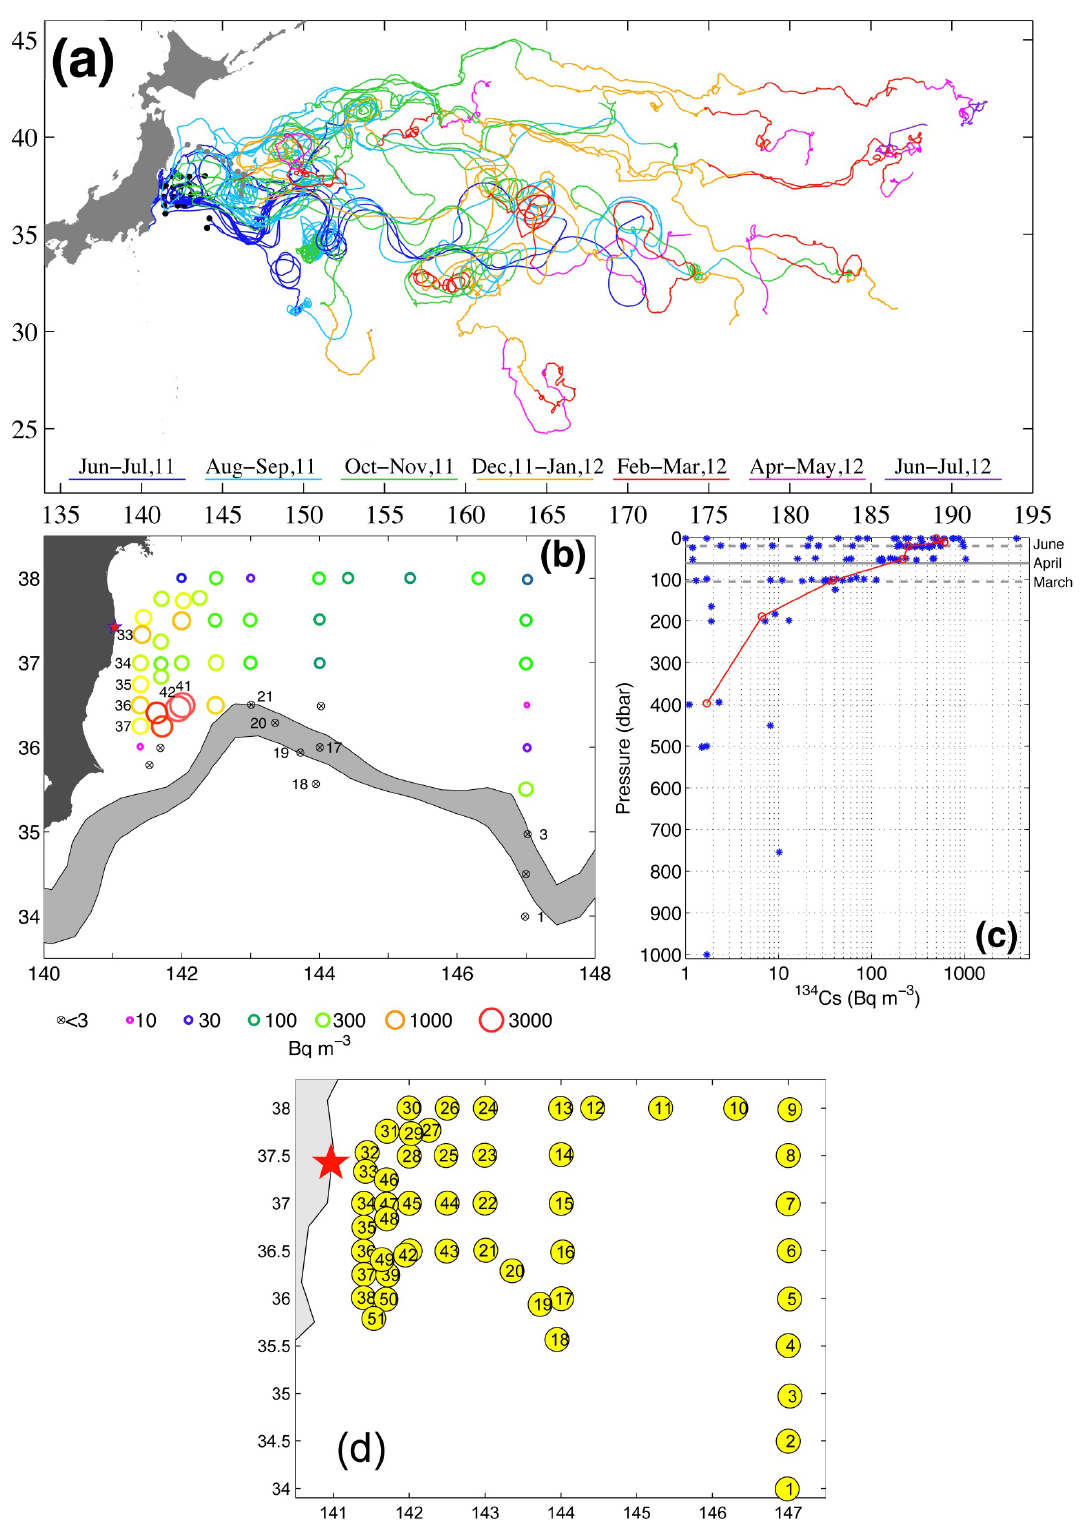
Fig. 1. (a) Color-coded tracks of 24 KOK and 12 Mirai cruise drifters. Initial positions are marked by black and gray dots for the KOK and Murai drifters, respectively. (b) Concentration of 134 Cs in surface water. Gray shading shows the average position of the Kuroshio Current. (c) KOK -observed water column distribution of 134 Cs. Mean vertical profile of 134 Cs is shown in red. KOK area averaged mixed-layer depths in March, April and June estimated from Argo are shown by gray lines. (d) KOK station numbers and